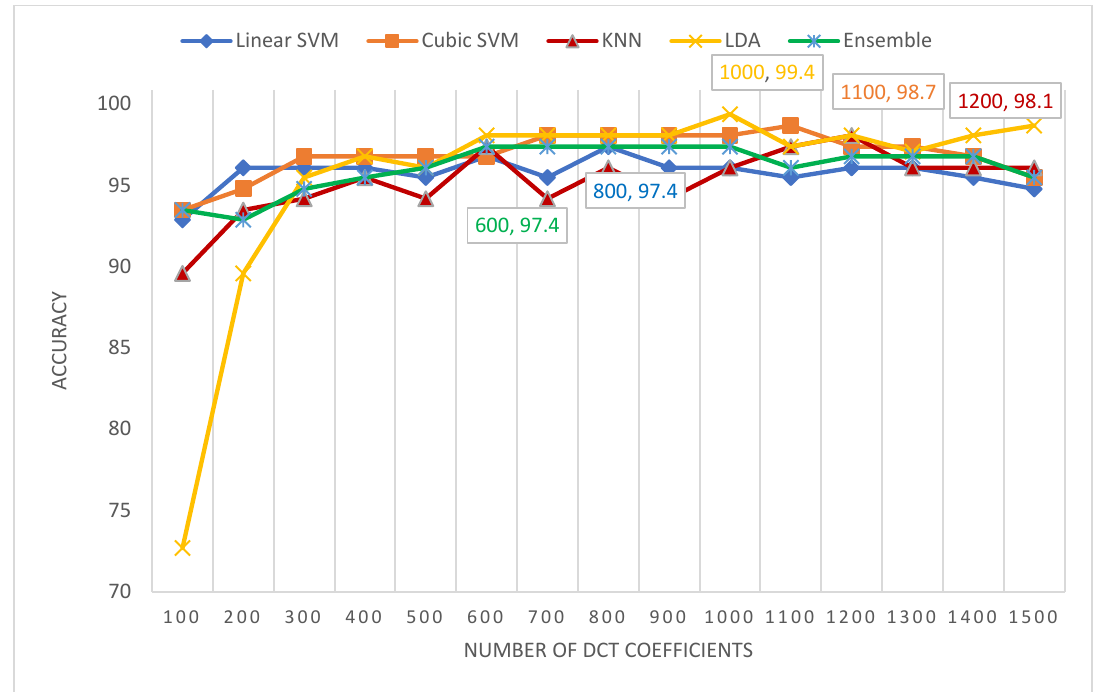
Figure 7. The number of DCT coefficients versus the classification accuracies attained for the five classifiers of MB-AI-His.